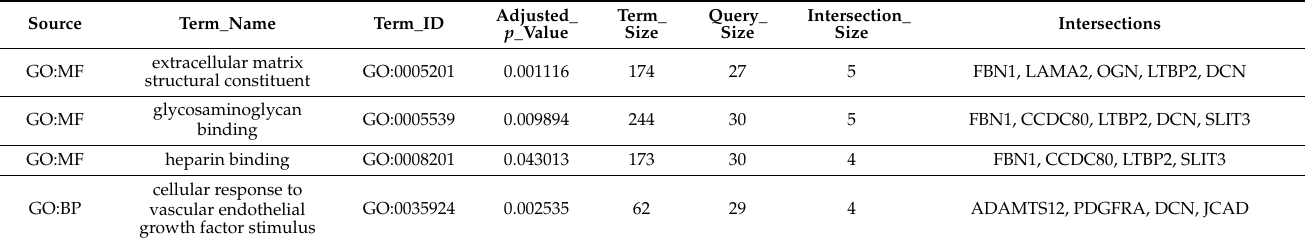
Table A4. Enriched function using AR-co-expressed genes in both